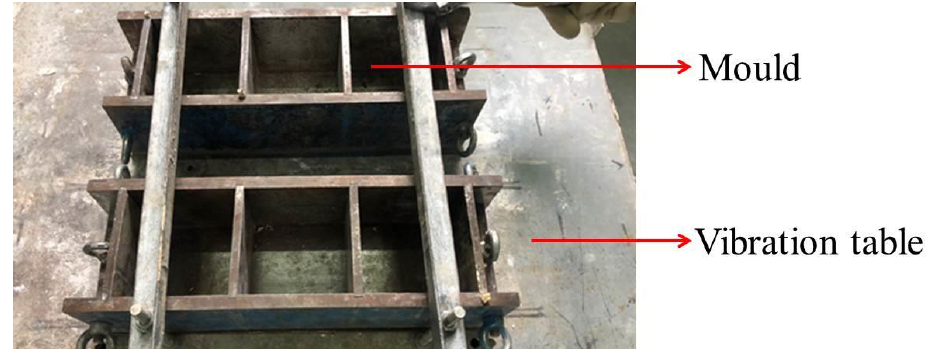
Figure 5. Mould and vibration table.